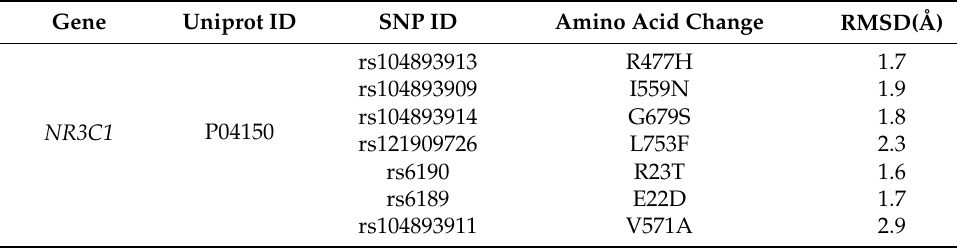
Table 3. RMSD value of NR3C1